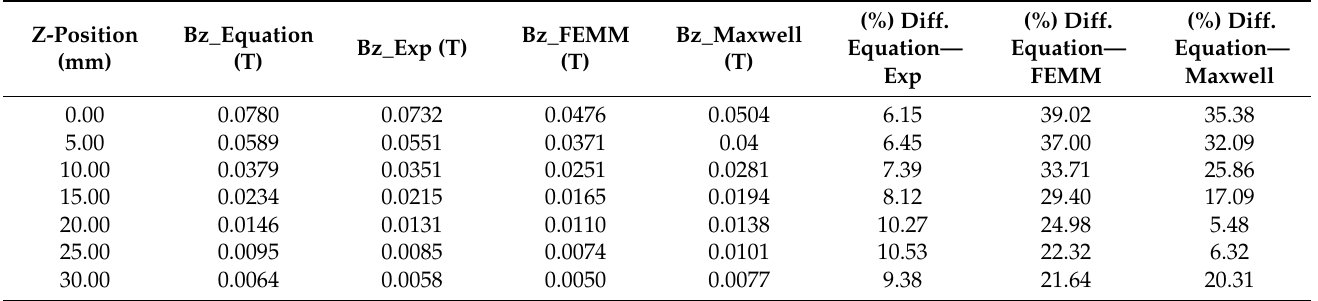
Table 6. Ferrite Y35-type permanent magnet B-field values compare different distances from the magnet